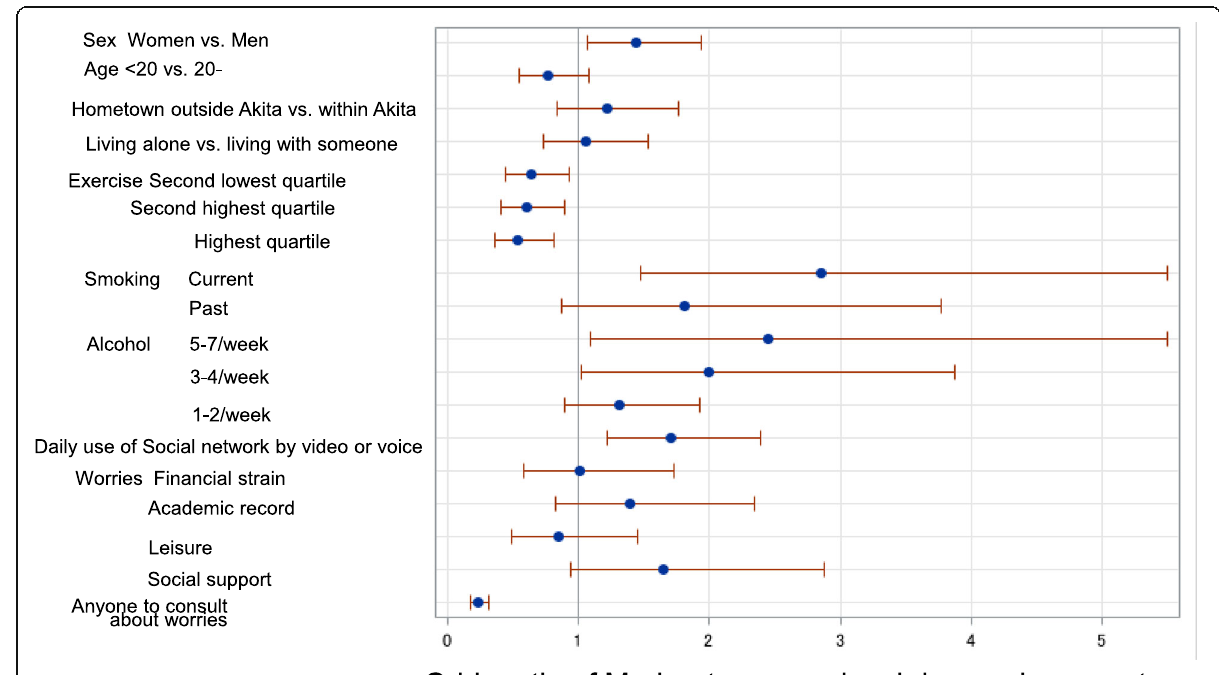
Fig. 1 Factors associated with moderate-severe level